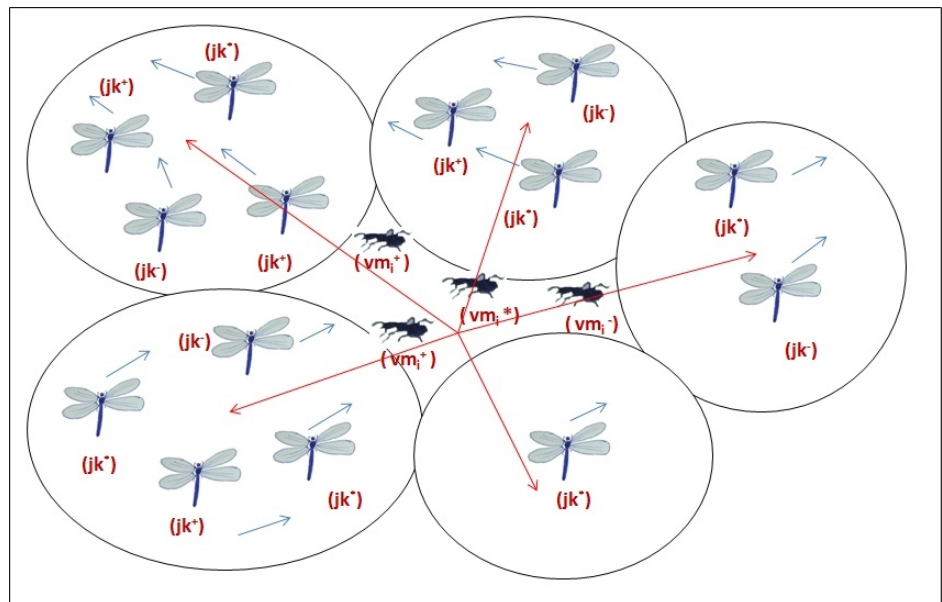
Figure 4: Swarming behavior of dragonfly load balancing